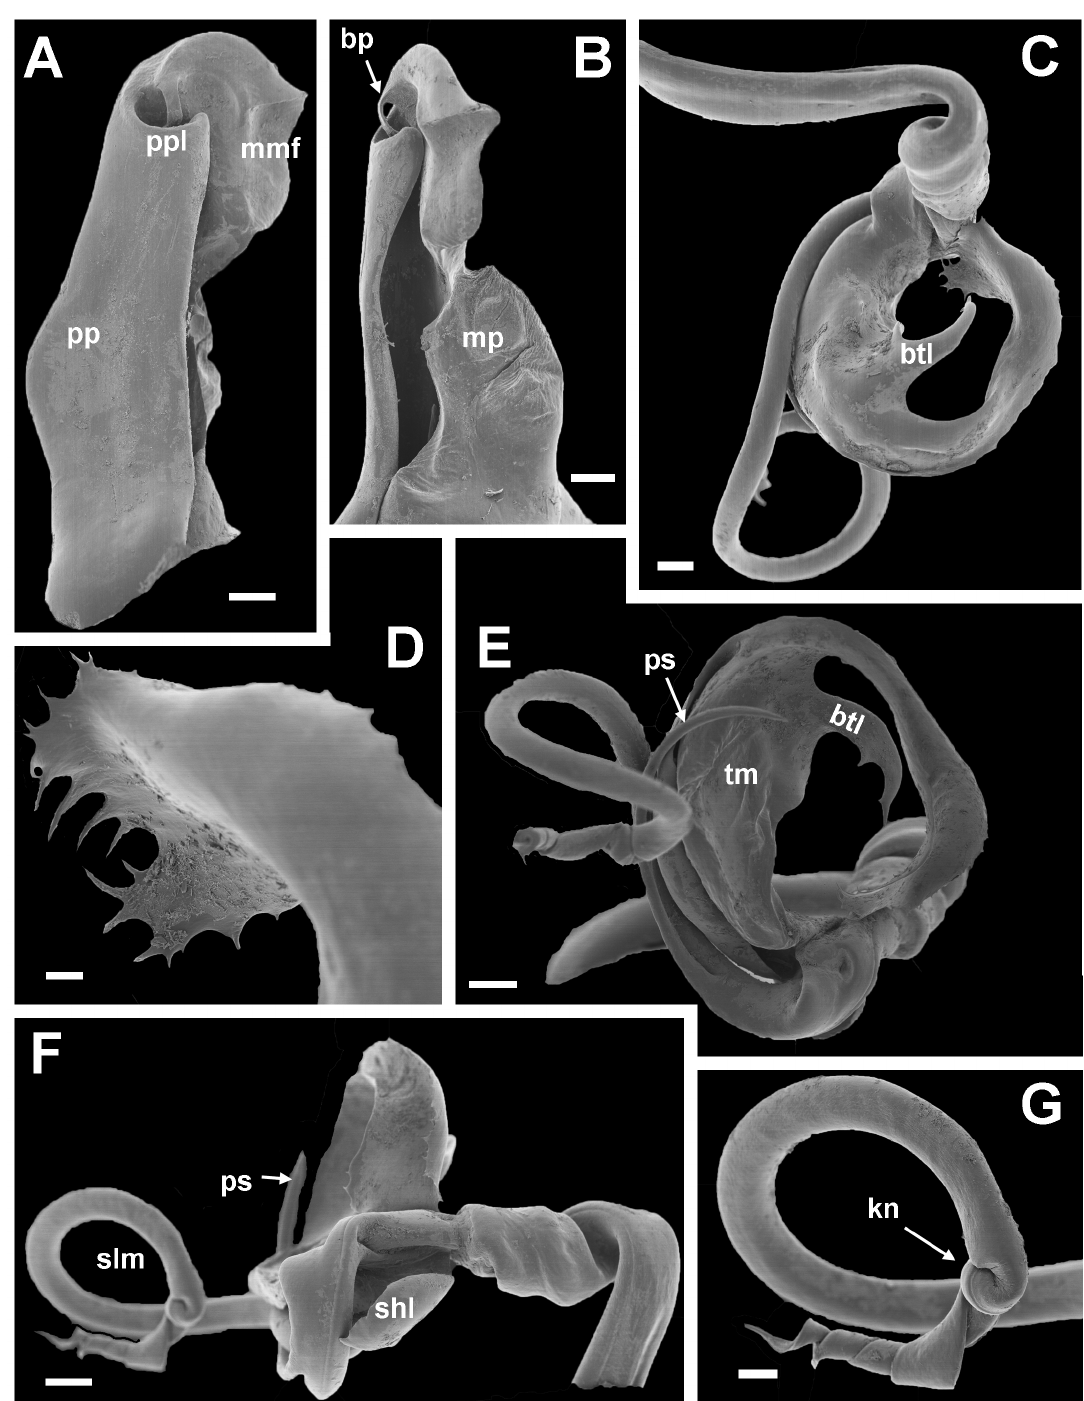
Fig. 6. Helicochetus mutaba Kraus, 1960, ♂, from Mazombo. Left gonopod. A–B . Coxa. A . Anterior view. B . Mesal view. C–G . Telopodite. C . Anterior-lateral view. D . Detail of C (tip of telomere). E . Mesal-posterior view. F . Anterior-ventral view. G . Detail of F (tip of solenomere). Abbreviations: bp = apical basad process of coxa; btl = basal lamella of telomere; kn = knob-like turn of solenomere; mmf = mesal metaplical flange; mp = metaplica; pp = proplica; ppl = proplical lobe; ps = proximal solenomeral spine; shl = shovel-like flange; slm = solenomere; tm = telomere. Scale bars: A–C, E–F = 0.2 mm; D = 0.05 mm; G = 0.1